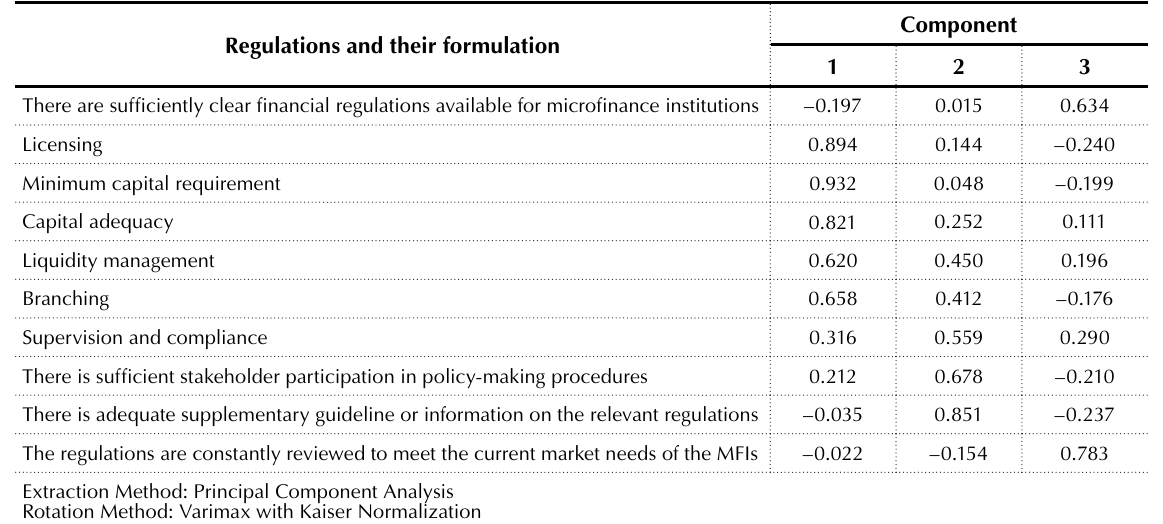
Table 1. Rotated Component Matrix*